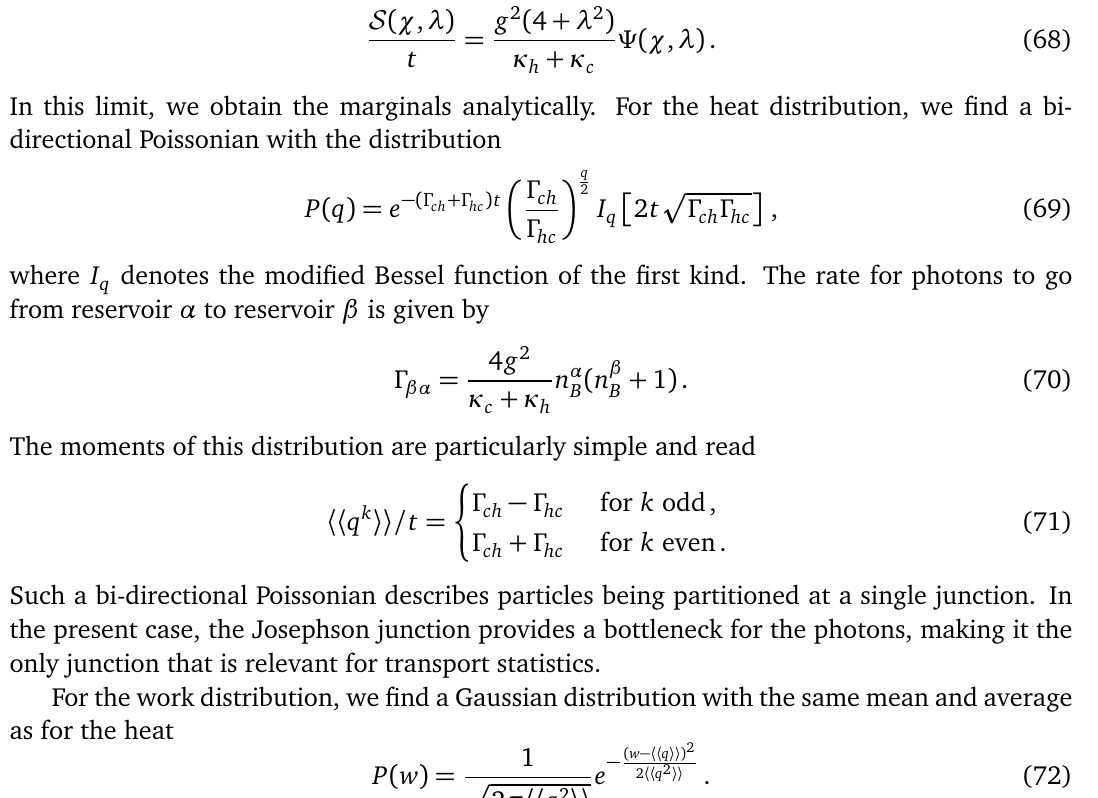
= 1, n c = 0.1, gt = κ t = B B